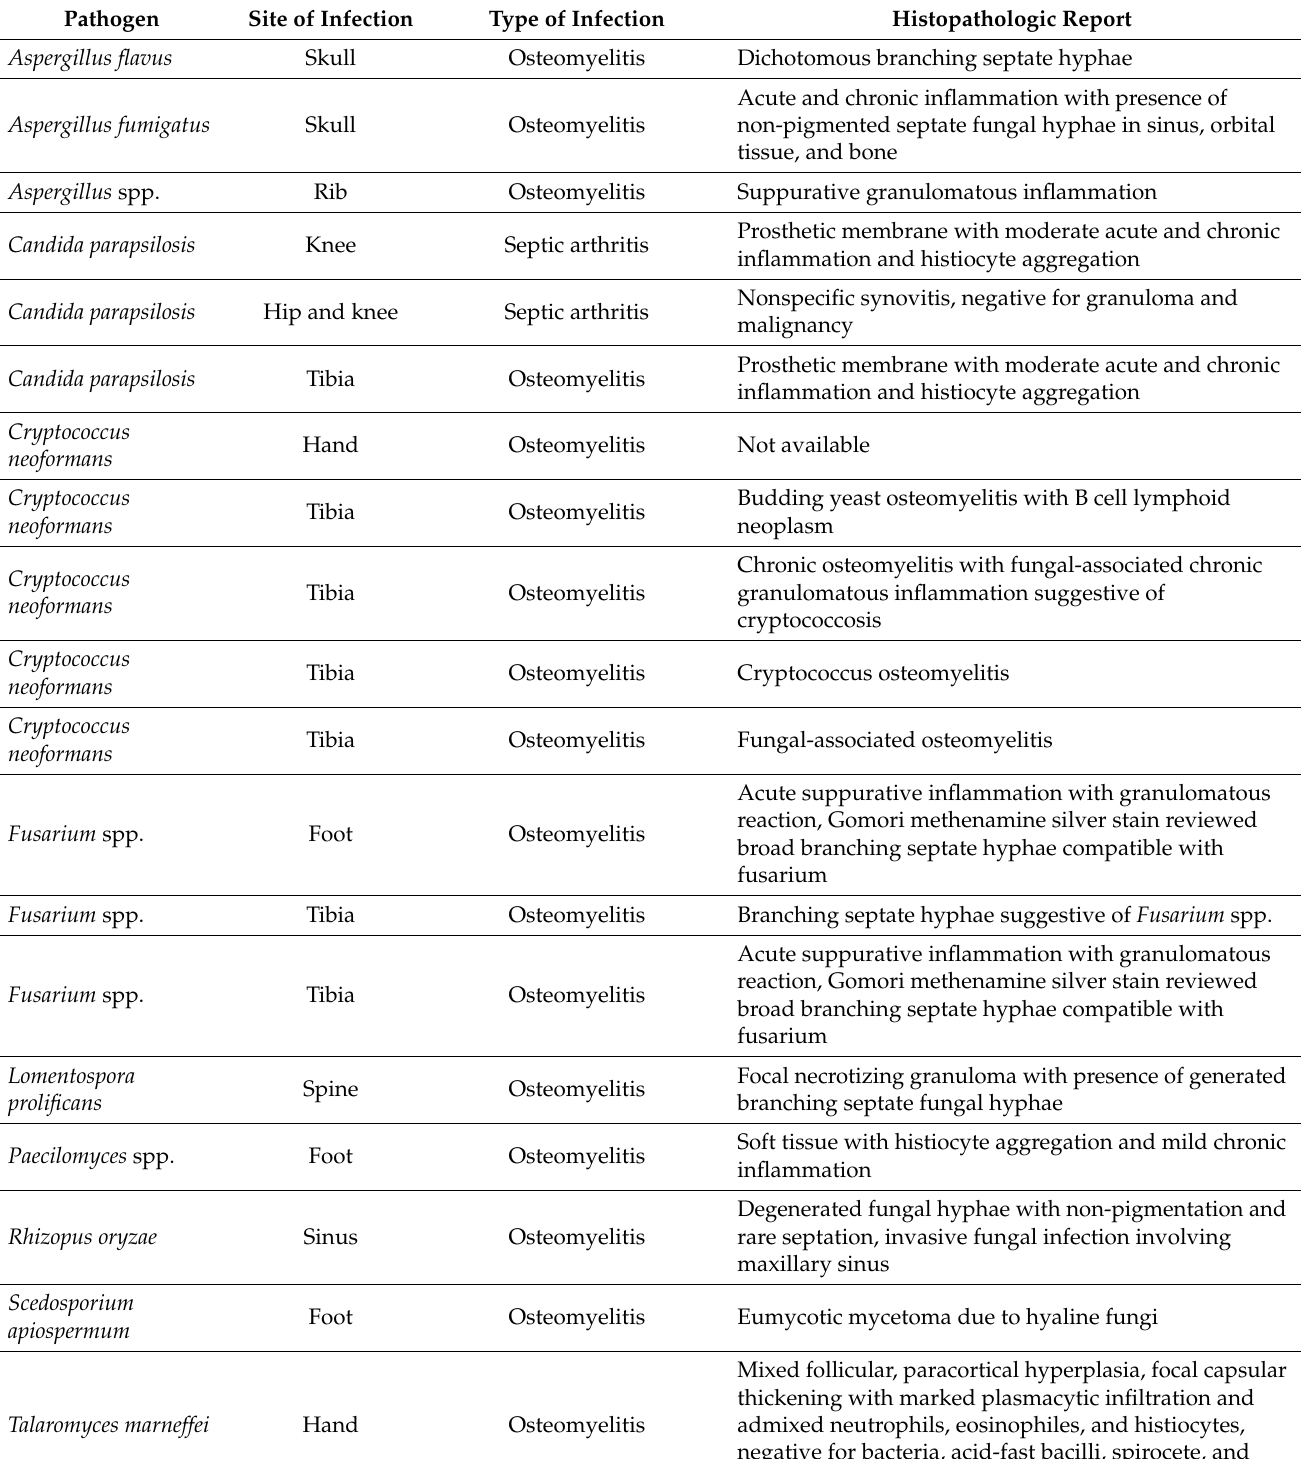
Table 1. Pathogen, site of infection, type of infection, and histopathologic findings in patients with fungal musculoskeletal